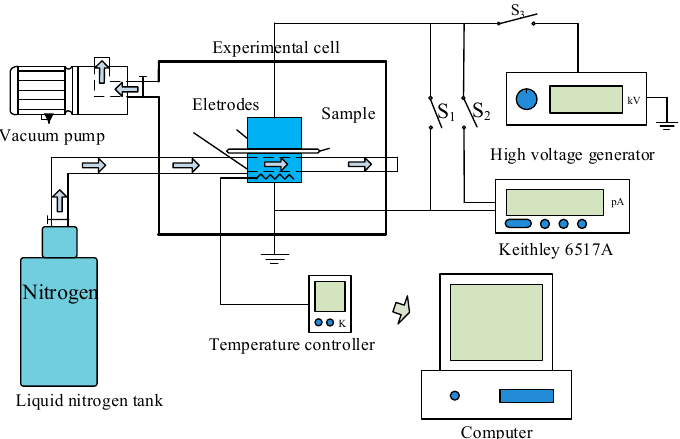
2 -modified RIP, the